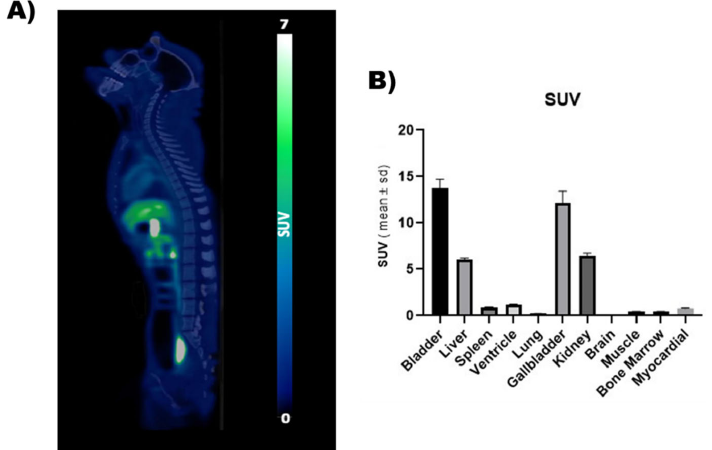
Figure 3. PET imaging of a non ‐ human primate using [ 18 F]DTG. ( A ) Representative whole ‐ body [ 18 F]DTG PET ‐ CT image obtained in a healthy macaque. PET signal is expressed in SUV units. ( B ) SUV (calculated as the mean value at the equilibrium between 150 and 180 min) in the organs of